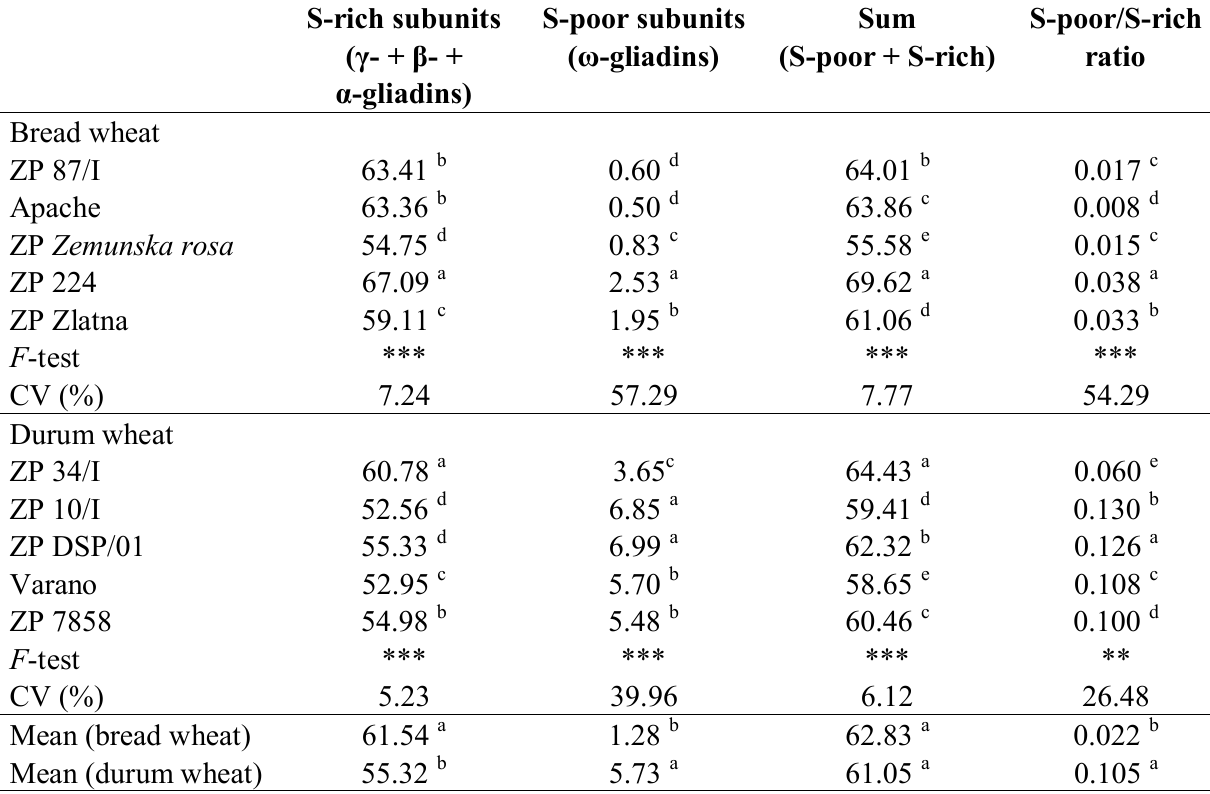
Table 4. Concentration of gliadin S-poor and S-rich subunits in grains of different bread and durum wheat genotypes (% of total extractable